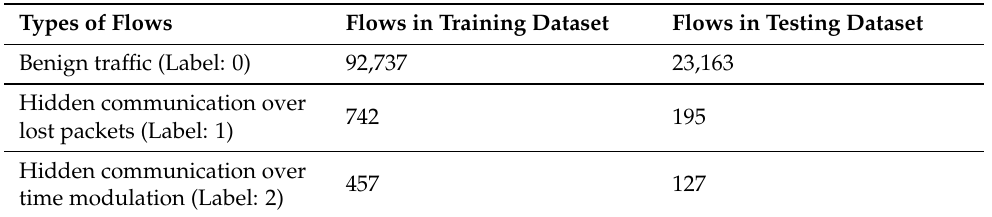
Table 4. Distribution of flows among training and test datasets split from collected dataset as described in Section